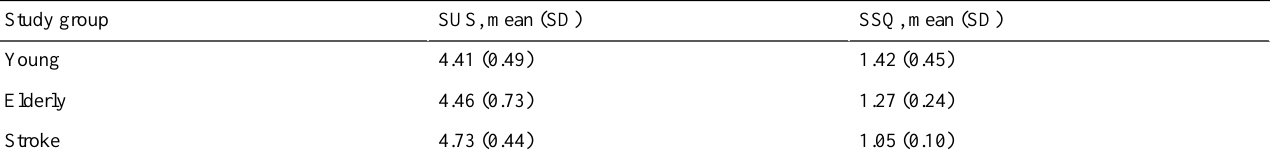
Table 4. Results of the System Usability Scale (SUS), where 1 means “unusable” and 5 means “very usable,” and the Simulator Sickness Questionnaire (SSQ), where 1 means “None” and 4 means “Severe” side